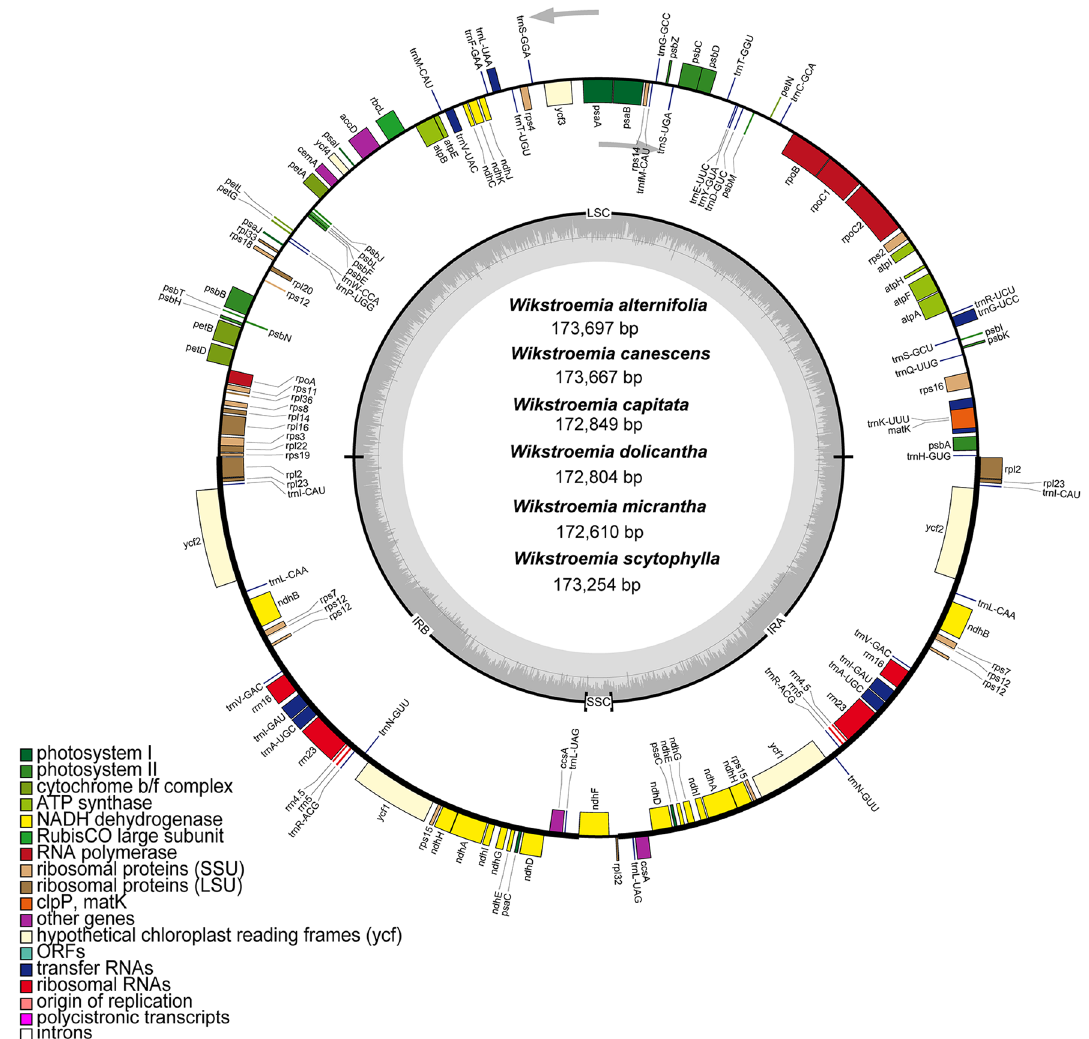
Figure 1. Gene map for the plastomes of six species of Wikstroemia used in this study. Genes on the inside of the map are transcribed in the clockwise direction; genes on the outside of the map are transcribed in the counterclockwise direction. Darker grey in the inner circle represents the GC content, whereas light grey corresponds to the AT content. Different functional groups of genes are shown in different colours. The gene map was generated using OGDRAW 45